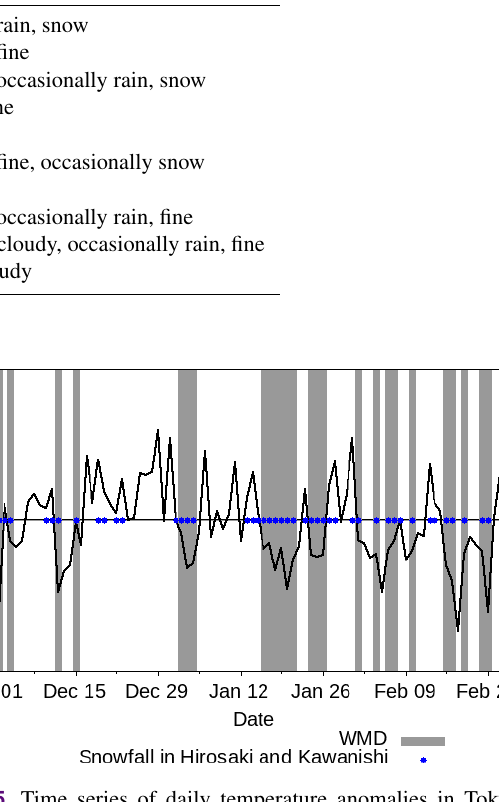
Figure 5. Time series of daily temperature anomalies in Tokyo (black solid line) and the dates of winter monsoon outbreak days (WMDs) for 1851/52. The blue dots indicate snowfall in Hirosaki and Kawanishi, and the gray shaded bars indicate WMDs. Tempera- ture anomalies were calculated as deviations from daily climatology for